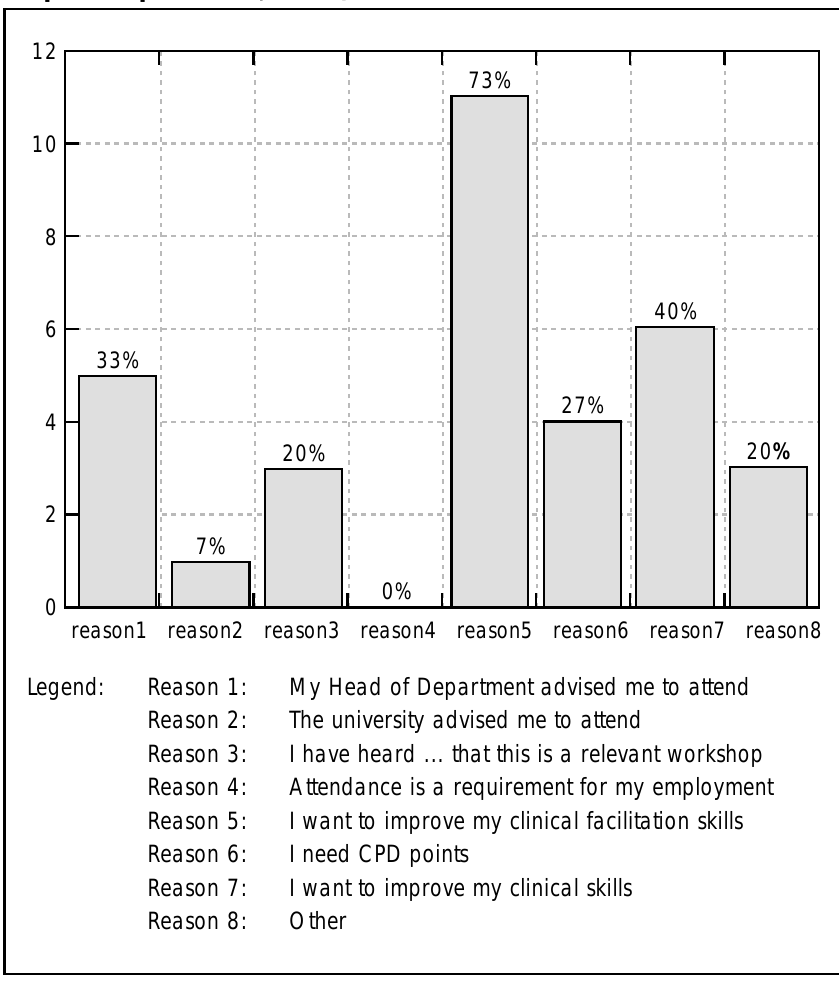
Figure 3: Reasons why participants attended the workshop (multiple responses permitted; n=15).